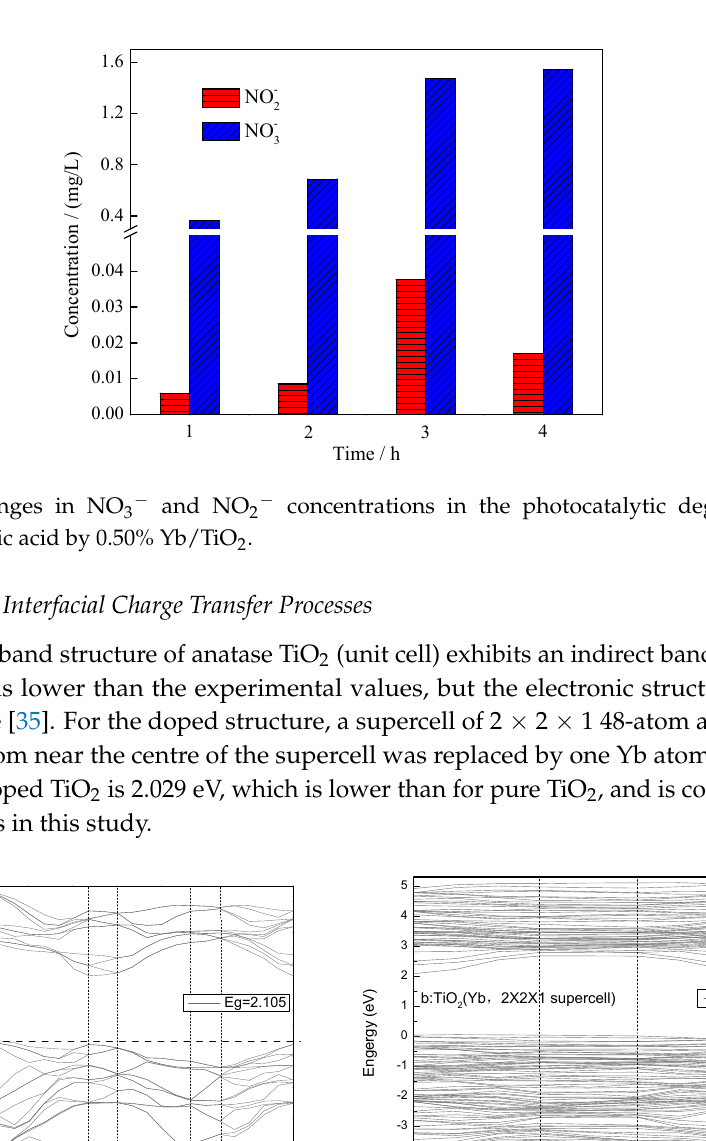
Figure 11. The calculated density of states of pure TiO 2 and Yb-doped TiO 2 (2 × 2 × 1 supercell). The photocatalytic mechanism of Yb/TiO 2 may be related to the 4f electronic structure of Yb and its variable valences (+2, +3). Yb 3+ in Yb/TiO 2 trapped the photoexcited electrons to translate to Yb 2+ . Yb 2+ was translated to Yb 3+ again by release of an electron, and the released electron could be easily captured by O 2 adsorbed on the surface of TiO 2 to produce ·O 2 − [9]. On one hand, the process above could inhibit the recombination of photoinduced charge (Equations (4)–(6)); on the other hand, the produced ·O 2 - could enhance the oxidation of BHA (Equation (7)). Yb 3+ + e − → Yb